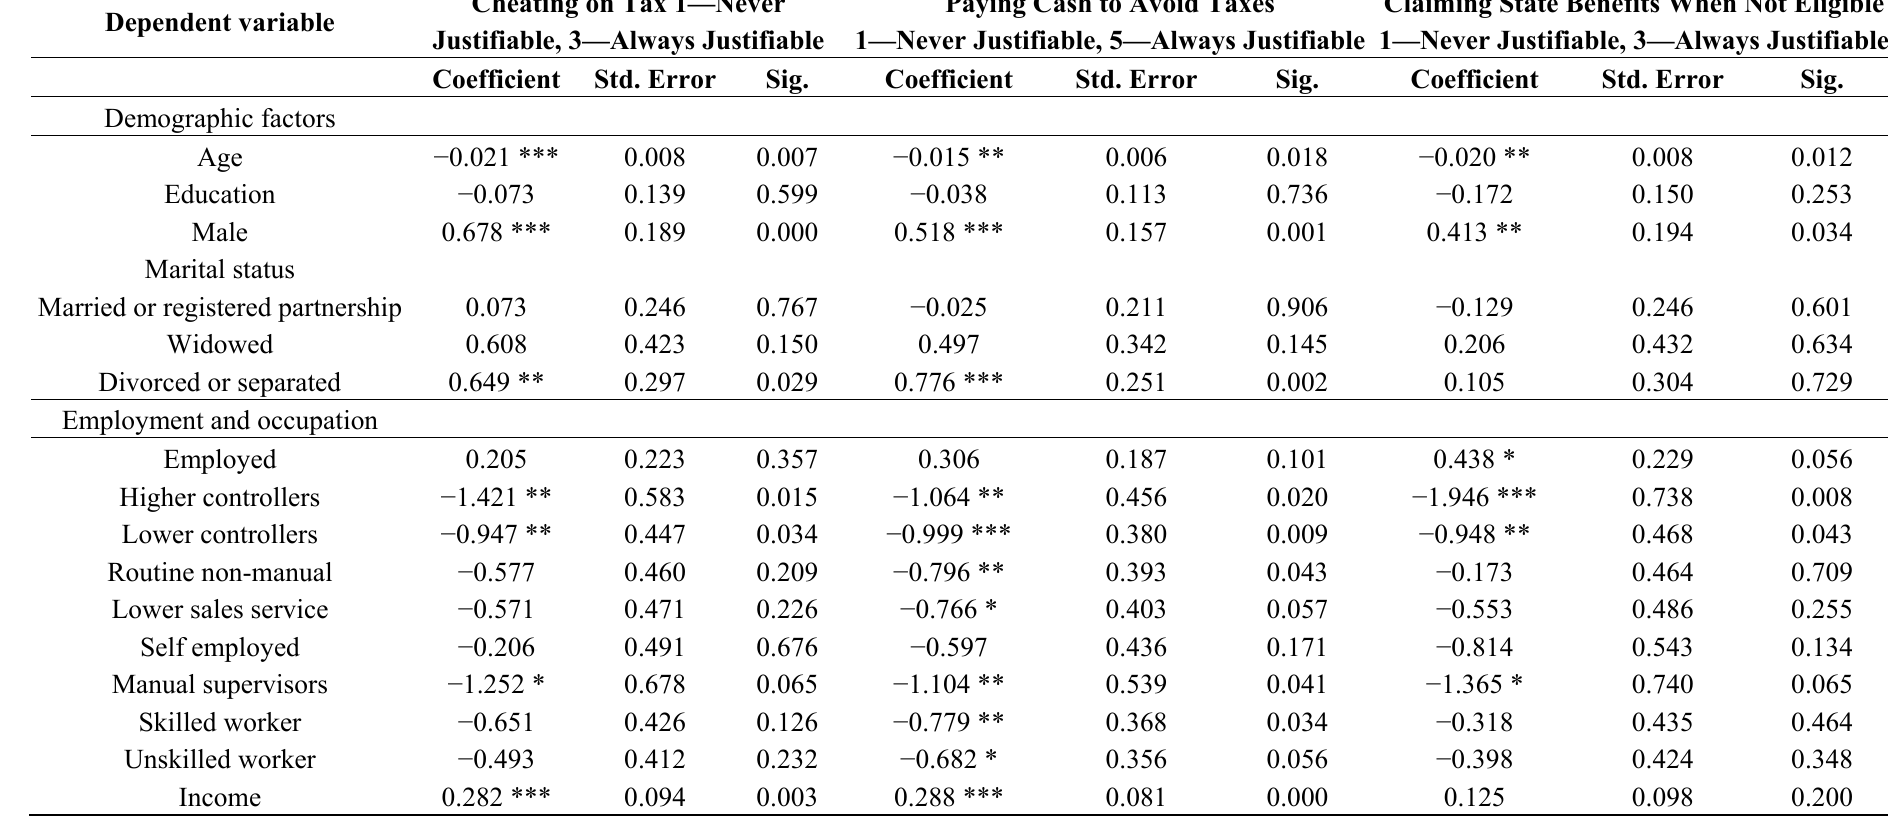
Table 2. Determinants of tax morale in the Czech Republic, ordered Logit